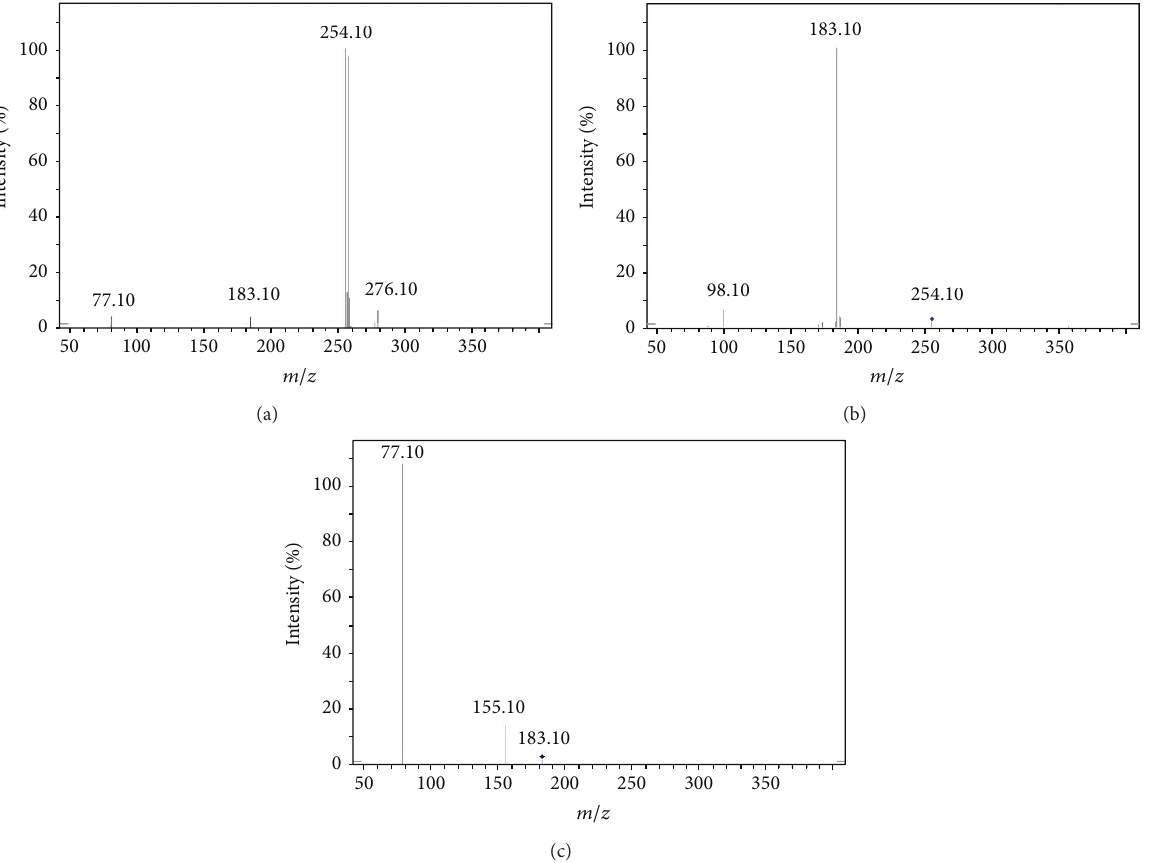
Figure 4: (a) Ion trap MS/MS mass spectrum of compound 4f [M + H] + ion ( m/z 254.10). (b) MS 2 spectrum of m/z 254.10. (c) MS 3 spectrum of